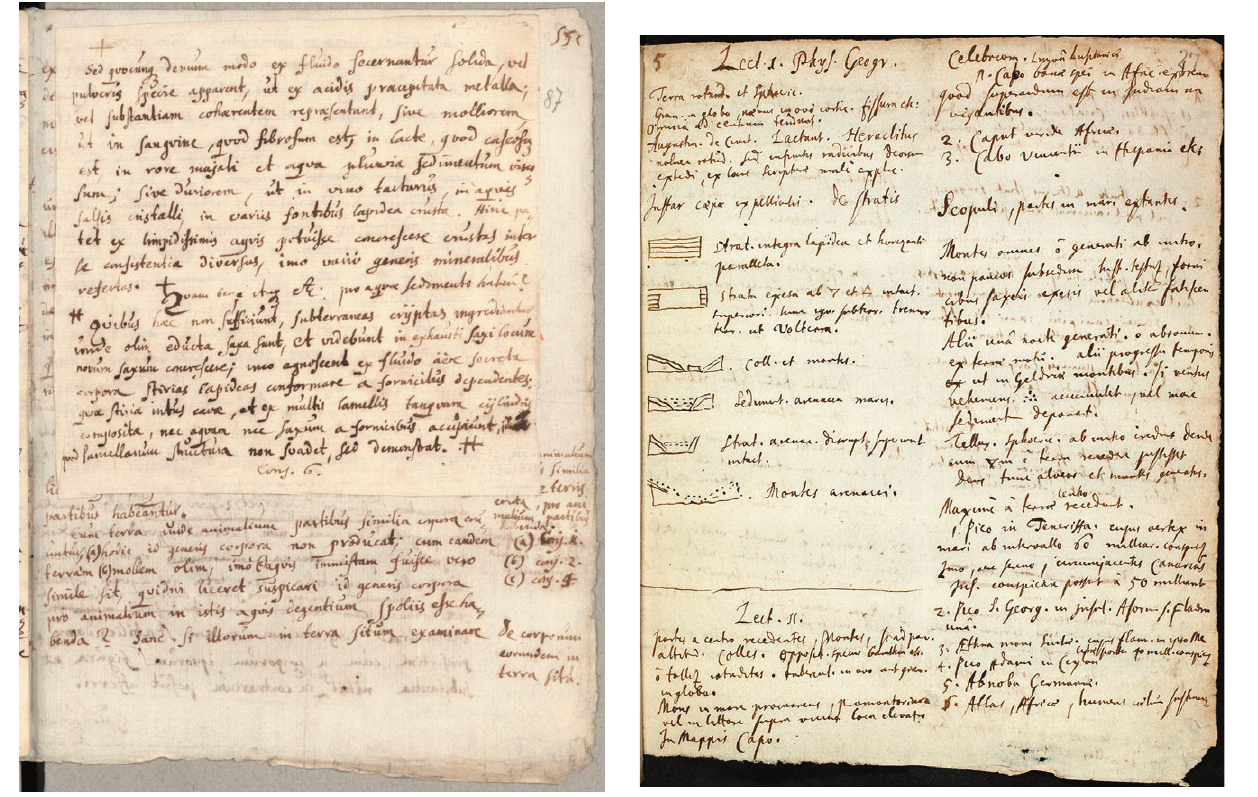
Figure 6. Page 81 from the Canis manuscript, part of Elementorum Myologiae Specimen , Royal National Library, Copenhagen, open access from www.kb.dk. Corrections and added subheadings in the margin are in Steno’s handwriting (see also Fig. 5).